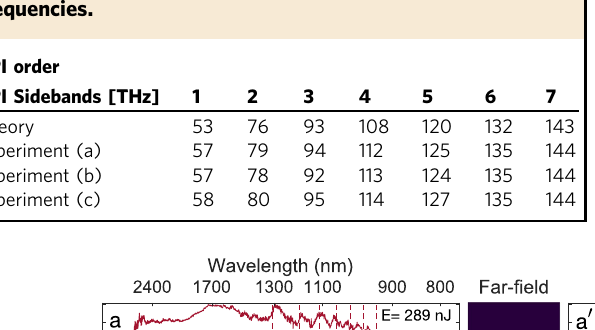
Table 1 Comparison of theoretically calculated (see Methods) and experimentally measured GPI sideband frequencies.